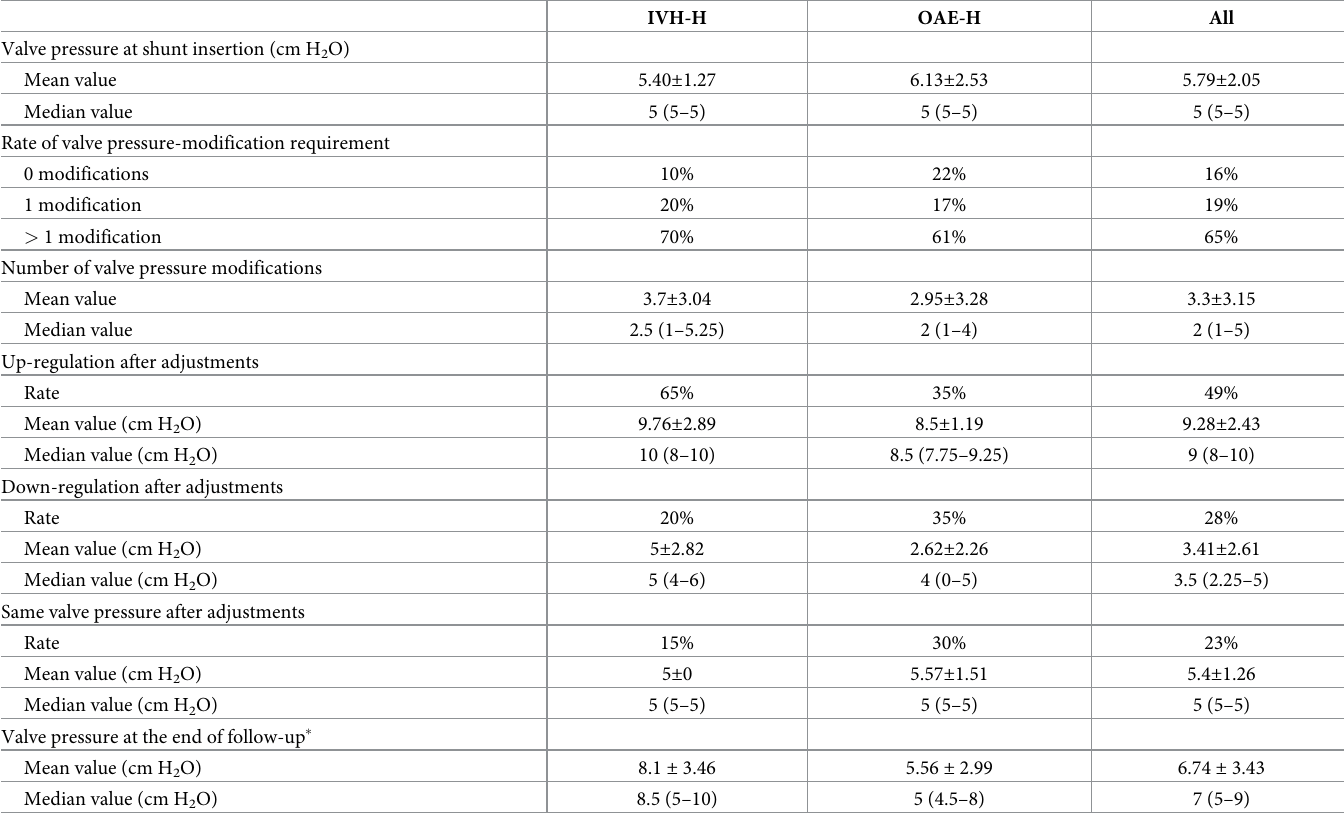
Table 2. Amount and direction of valve pressure regulation.